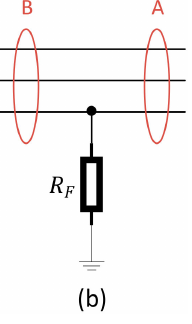
Figure 2. Single line diagram of a distribution network. ( a ) two arbitrary secondary substations are shown which indicates that the following analysis is valid for any point on the feeder. ( b ) B and A are not electrically the same location.